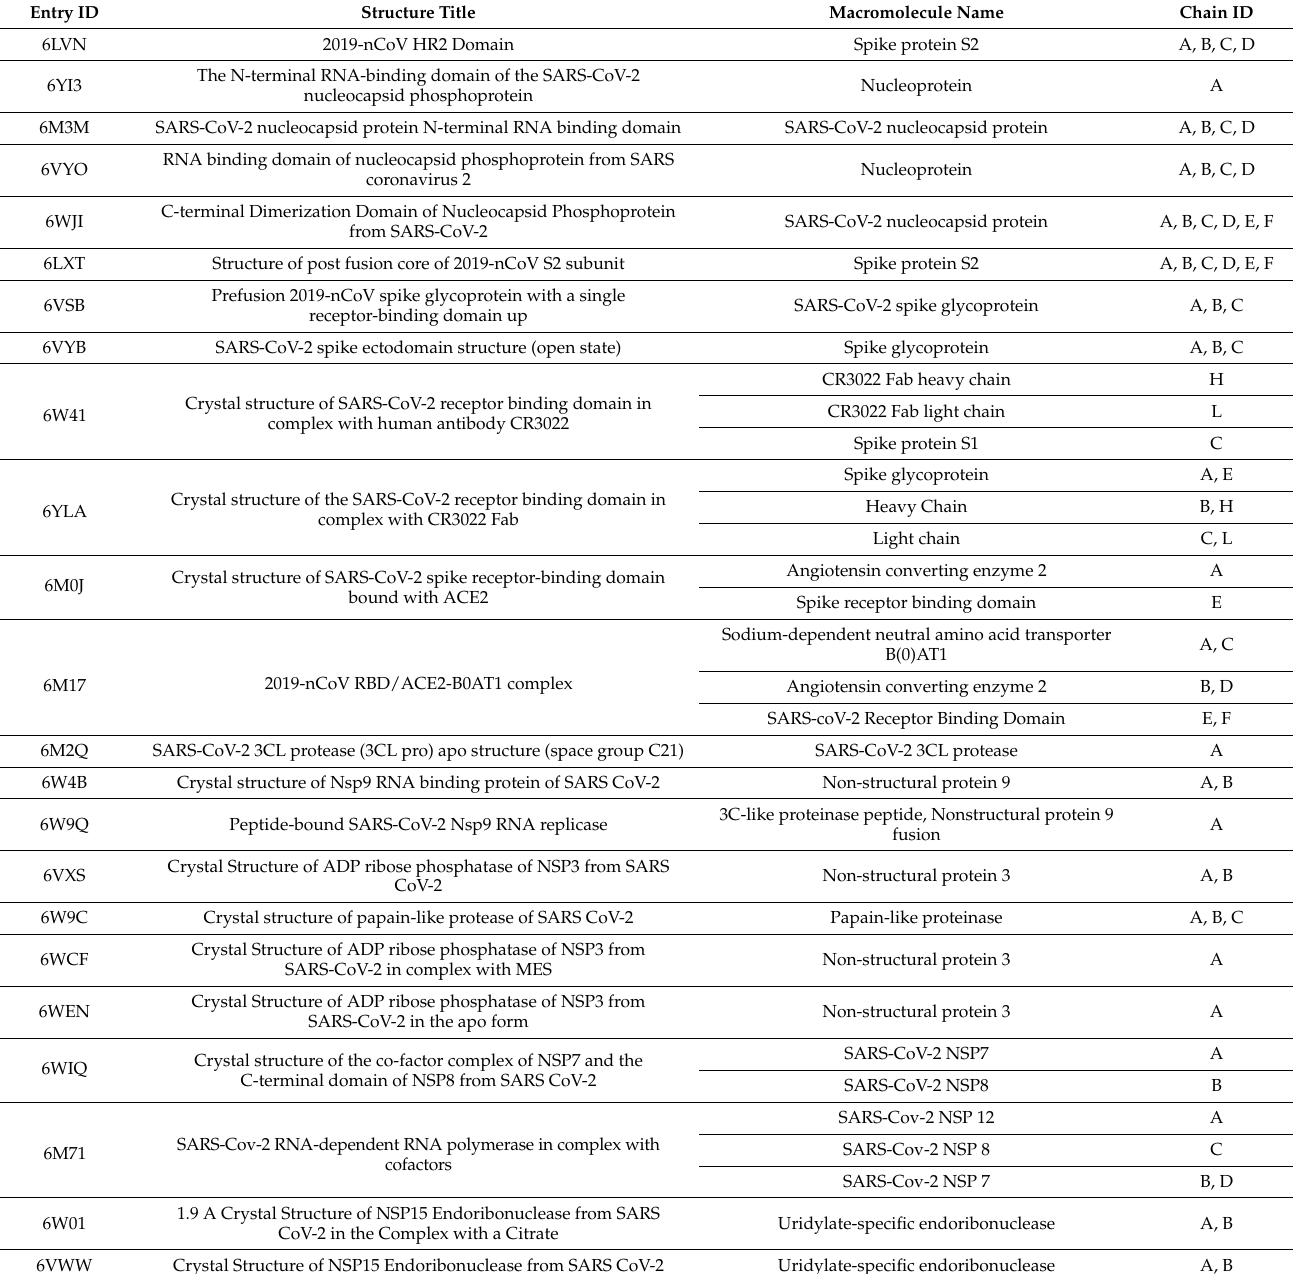
Table 1. Protein Data Bank (PDB) structures of SARS-CoV-2 proteins analyzed in the study. Entry ID (column 1) encodes the PDB identifyers of the analyzed protein structures, Structure Title (column 2) provides the protein structure description, Macromolecular Name (column 3) is the protein short name and Chain ID (column 4) are the studied